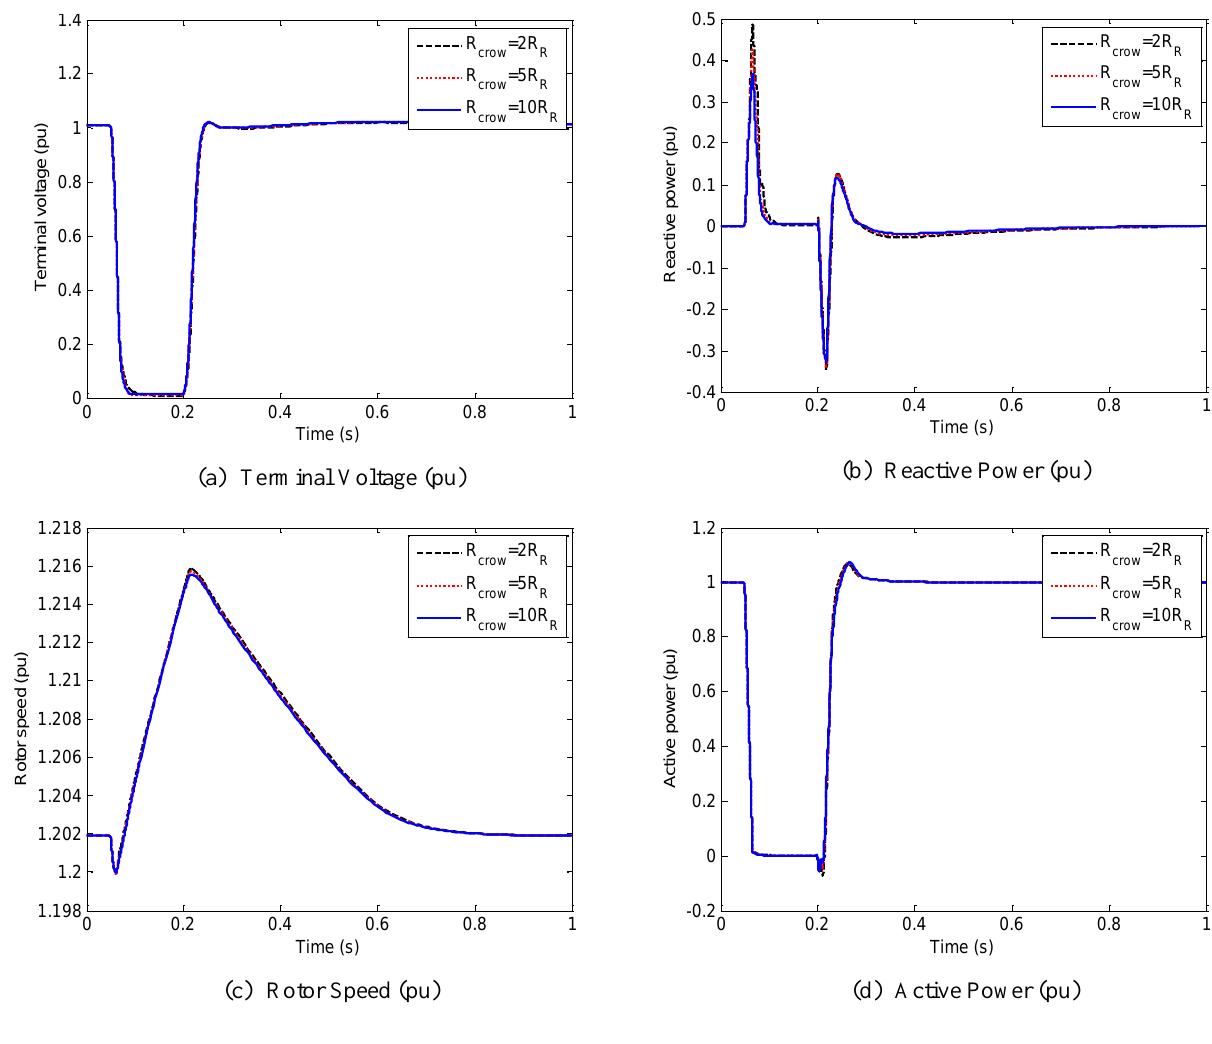
Figure 10. Dynamic analysis of the DFIG for different crowbar resistance value during a fault eliminated in 150 ms at